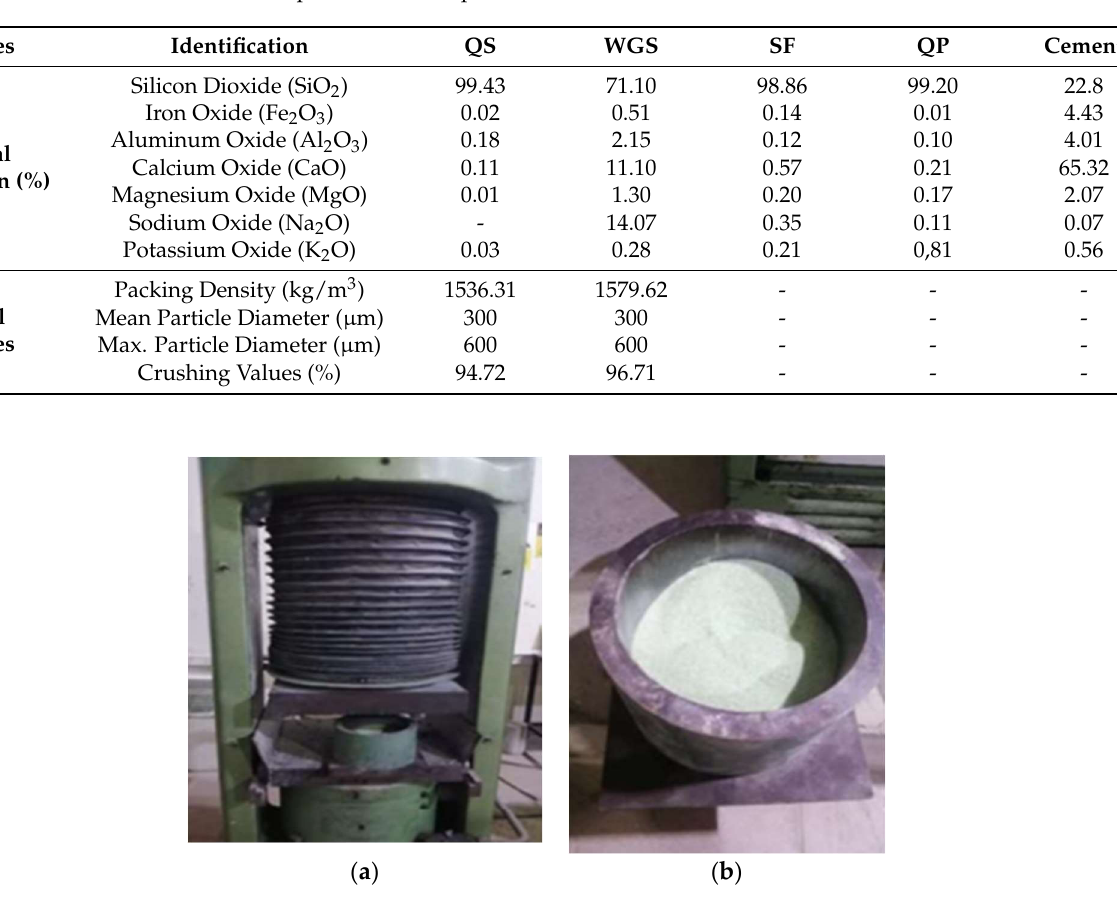
Figure 1. ( a ) Compressive Strength Machine; ( b ) Crushed Waste glass sand. Table 1. Properties and Composition of the Materials Used.